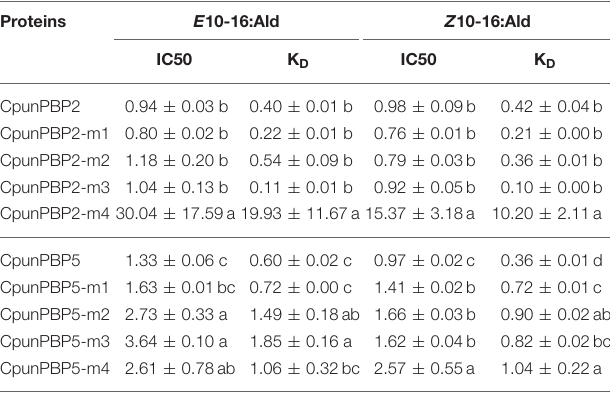
TABLE 4 | IC 50 values ( µ M) and calculated dissociation constants (K D ) ( µ M) of CpunPBP2 and CpunPBP5 with their mutants to two pheromones.